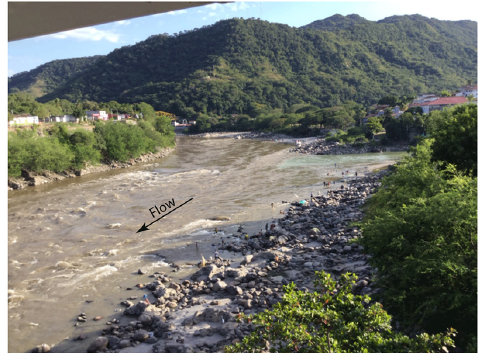
Figure 5. The “Rapidos de Honda”. Big boulders were carried here by the Gualí Tributary in the dramatic event of the Nevado del Ruiz eruption (This was also observed by Ordonez et al. [26]); they do not belong to the bedload transport of the contemporary Magdalena.